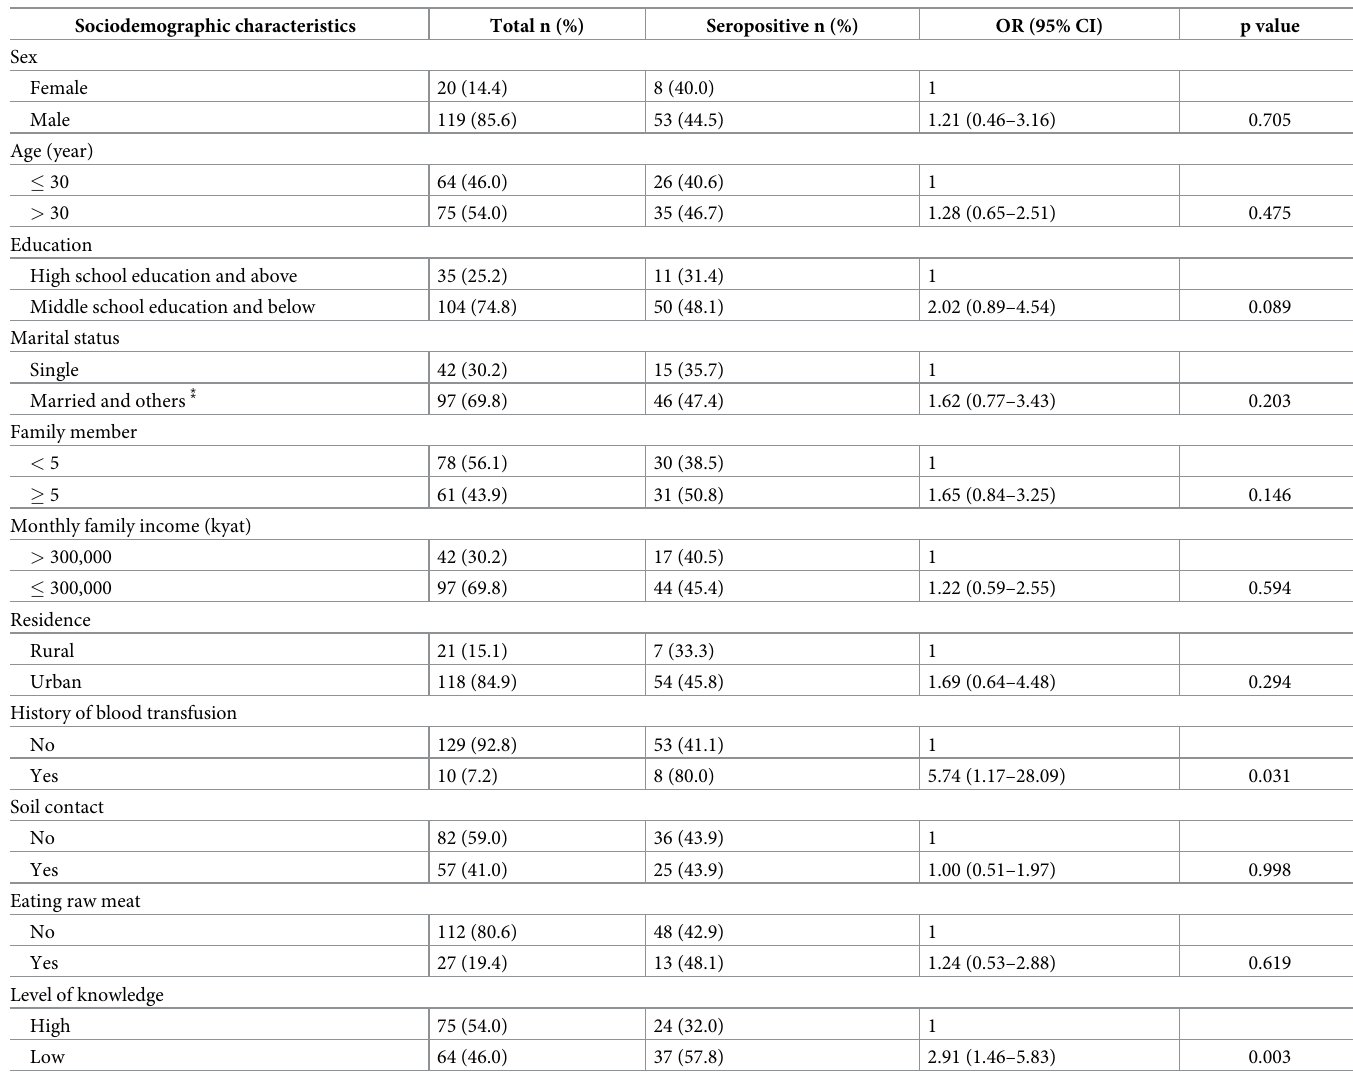
Table 2. Sociodemographic characteristics and level of knowledge associated with seropositivity of Toxoplasma gondii among slaughterhouse workers. Sociodemographic